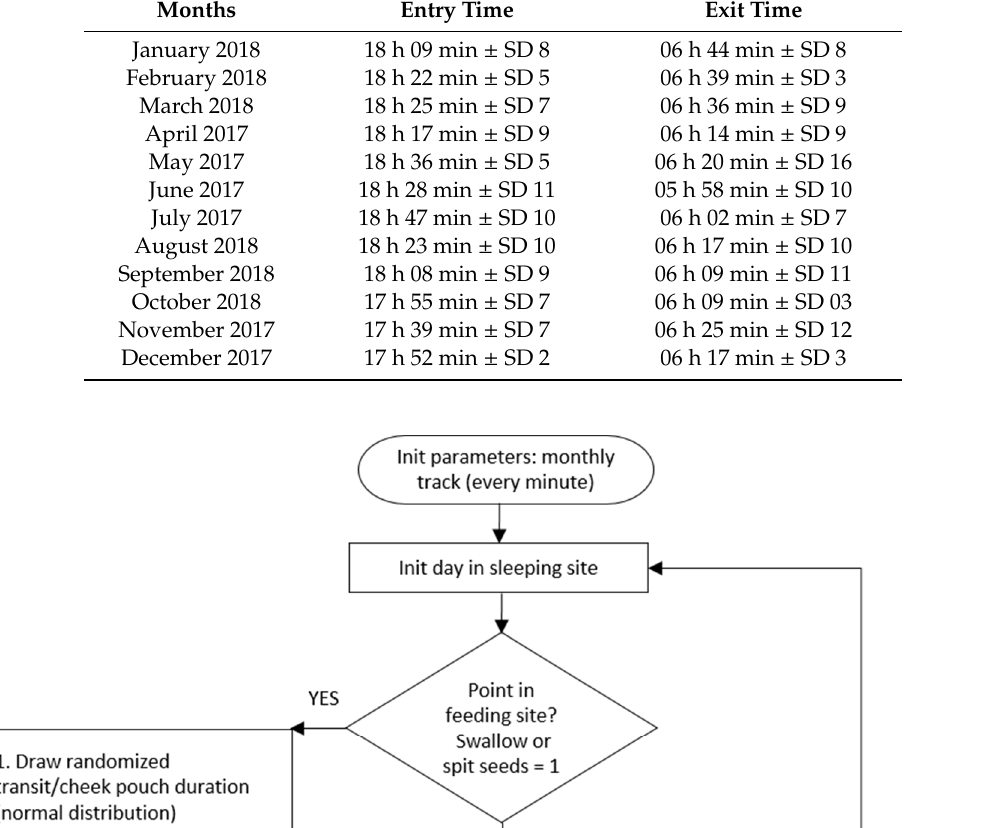
Table A1. Observed monthly entry and exit times to and from sleeping sites for the northern pigtailed macaques inhabiting the degraded forest of Sakaerat.